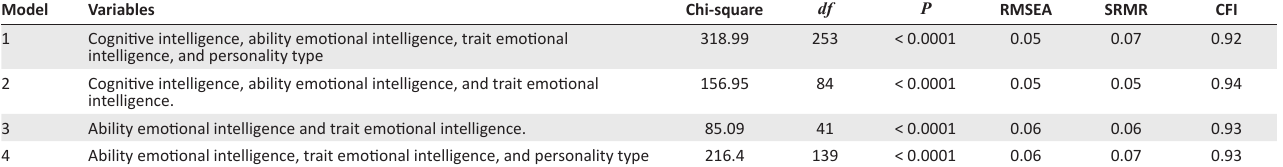
TABLE 5: Model fit statistics: Structural equation models. Model